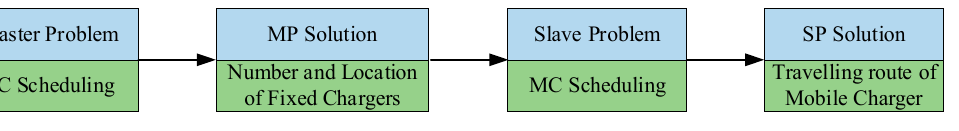
Figure 7. MSC problem-solving process.